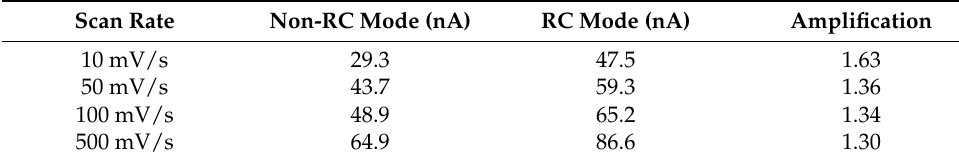
Figure 6. Redox cycling characterization of inner NRE 1 with scan rates ( a ) 10 mV/s, ( b ) 50 mV/s, ( c ) 100 mV/s, ( d ) 500 mV/s. The electrolyte is 5 mM Fe (CN) 63- in 1M KCl. The voltammogram of NRE 1 when NRE 2 is floating (black). The voltammogram of NRE 1 when NRE 2 is held at + 0.5 V (red). Table 1. Forward scan current (NRE 1) for RC and Non-RC mode